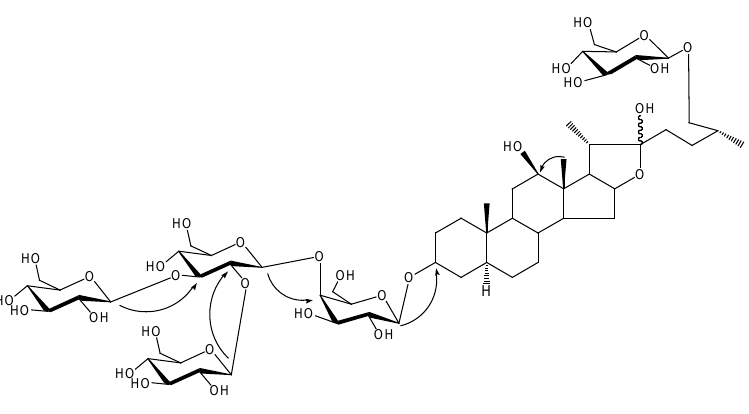
Figure 1. Key HMBC correlations of compound